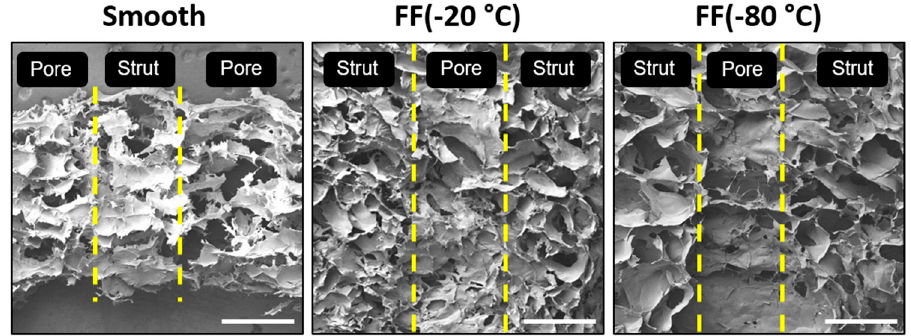
Figure 3. Vertical cross-sections of smooth and FF sca ff old struts. Both the − 20 ° C and − 80 ° C FF sca ff old struts had pores, while the smooth sca ff old struts did not. The yellow lines indicate the edges of struts and pores (macroscale pores). Scale bars are 1 mm.